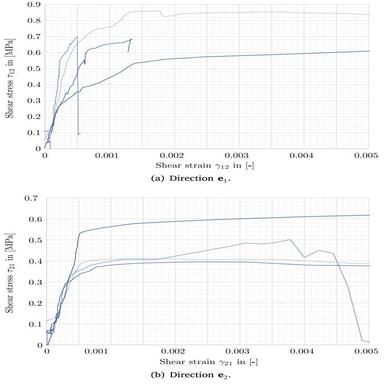
Macro shear stress–strain curves.